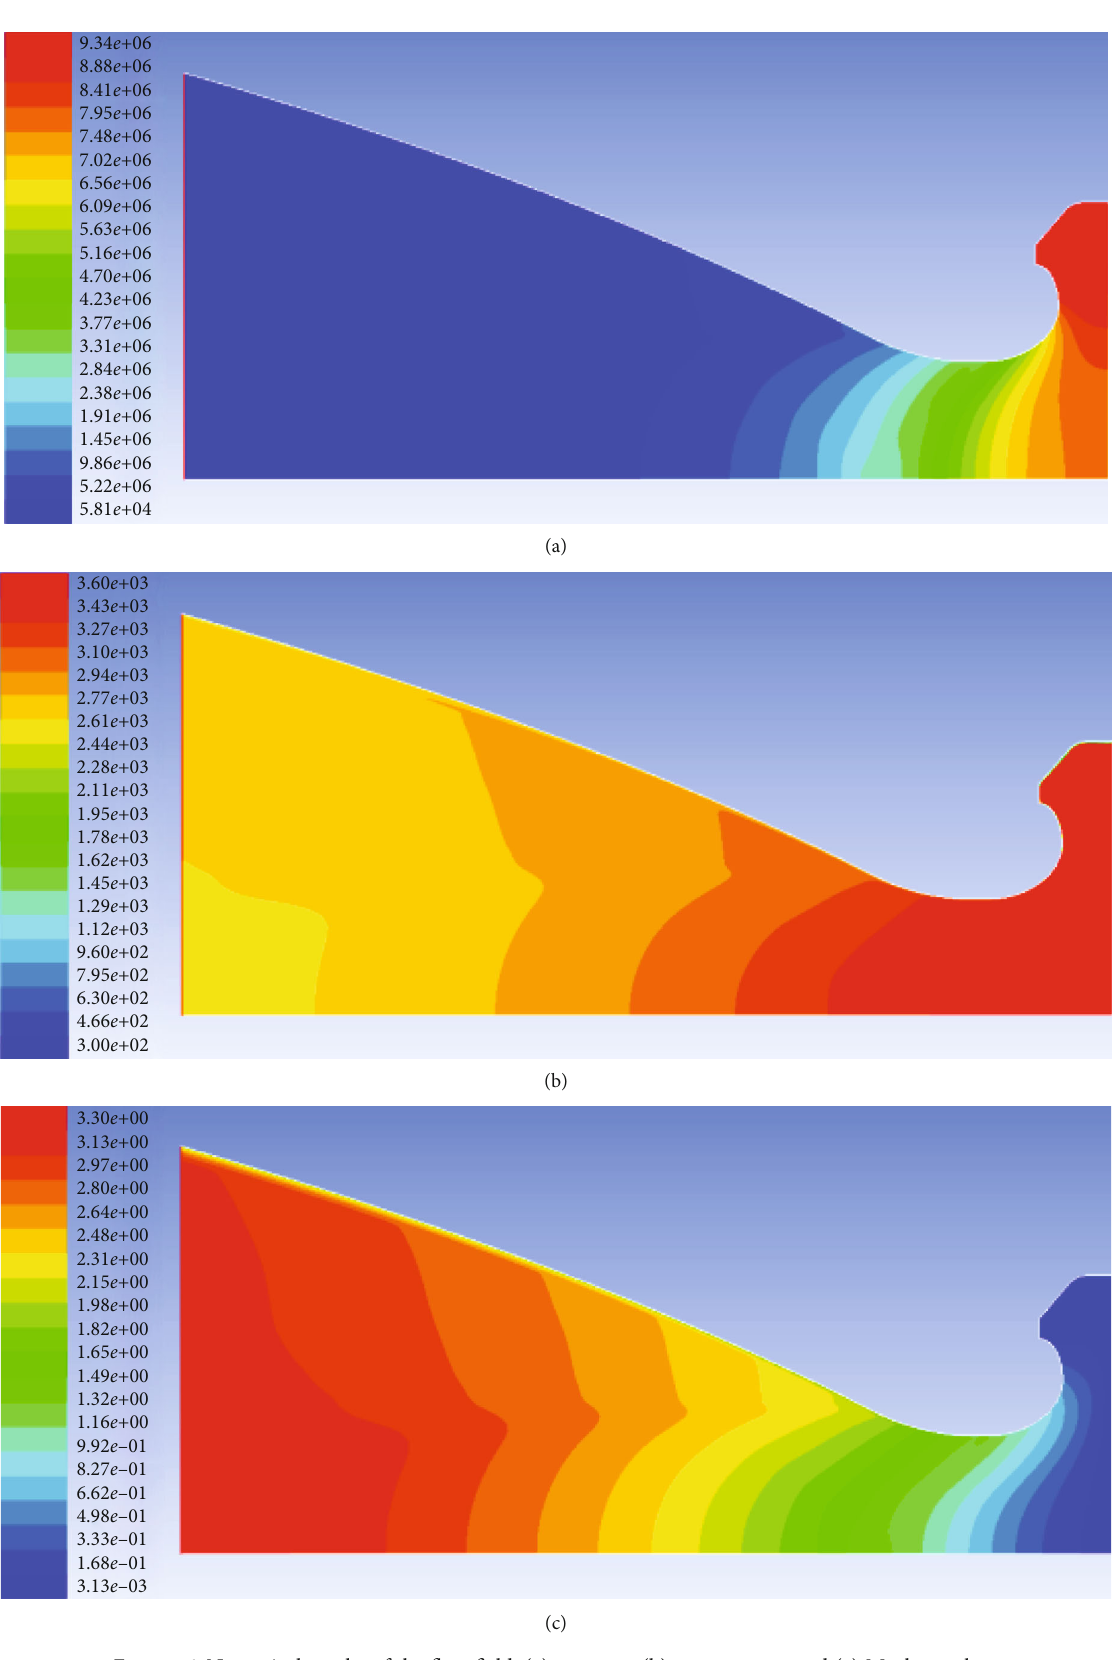
Figure 6: Numerical results of the fl ow fi eld: (a) pressure, (b) temperature, and (c) Mach